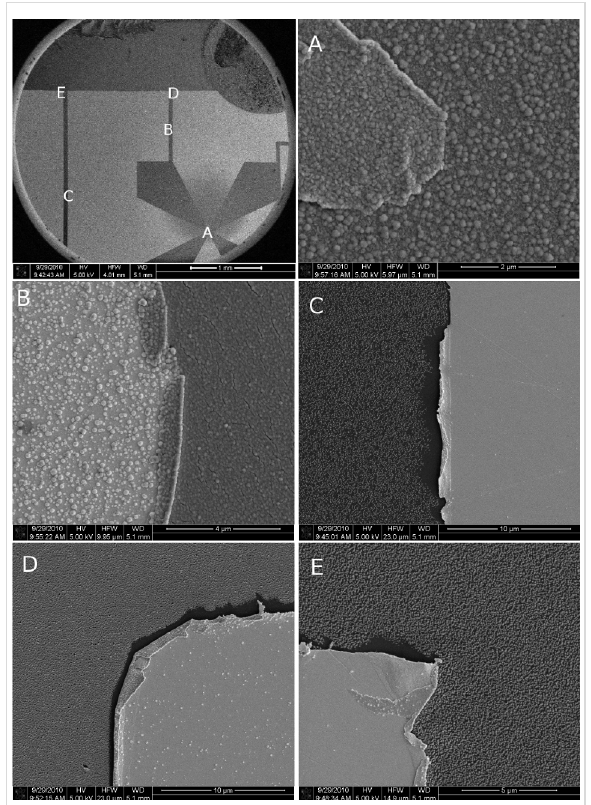
Figure 2: SEM images of Co deposited on the plasma-pretreated silicon oxide and gold. The picture on the top left is an overview of a SiO 2 surface prepatterned with Cr/Au contact structures. The labeling A–E indicates regions of different precursor flux, which was centered at A. The gas injection capillary is visible on the upper right. Gold surfaces appear as bright regions, SiO 2 surfaces as dark regions. Selected area SEM images are represented in images A–E.